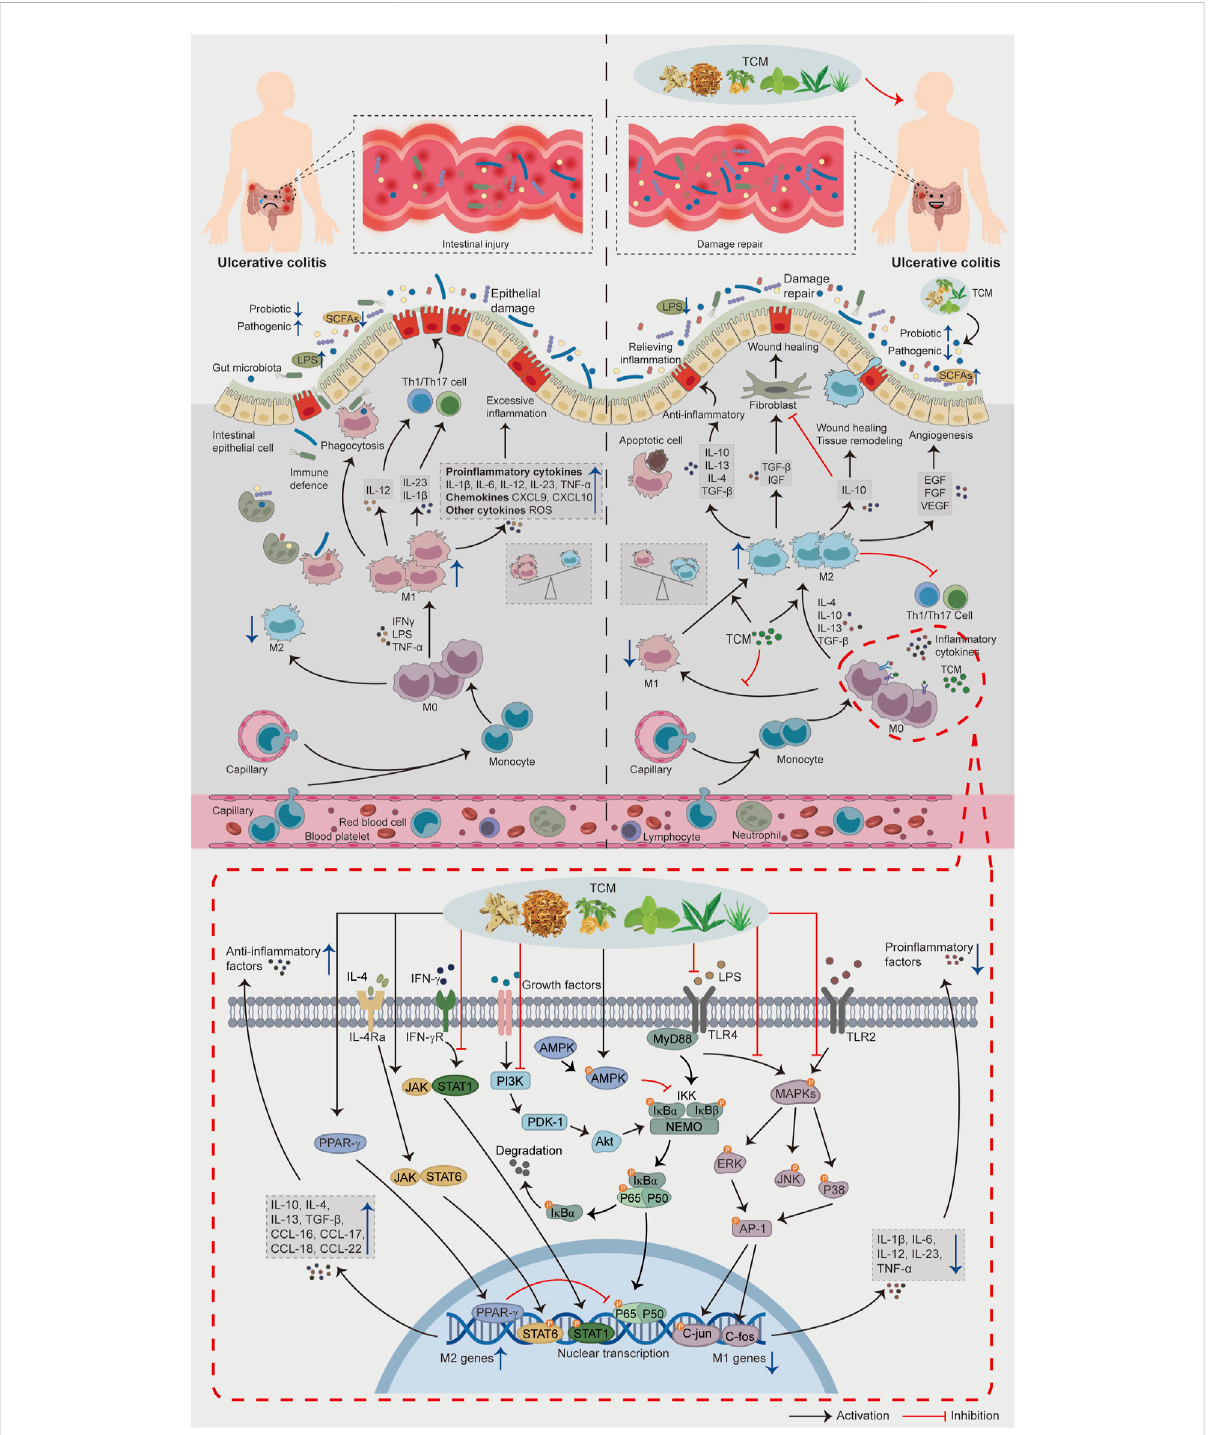
FIGURE 2 The role of intestinal macrophage polarization in the pathogenesis of UC and the potential mechanisms of TCM for UC based on intestinal macrophage polarization. When intestinal in fl ammation occurs in patients with UC, the lamina propria of the intestinal mucosa recruit a large number of monocytes and differentiate into immature M0 macrophages. Induced by a large number of pro-in fl ammatory factors (IFN γ , LPS, TNF- α ), macrophages polarizetowardtheM1phenotypeandsecretealargenumberofpro-in fl ammatorycytokines,chemokines,andin fl ammatorymediators,causingan imbalance in the regulation of intestinal in fl ammation, transforming the physiological in fl ammatory response into pathological intestinal injury and aggravatingtheconditionofUC.Inaddition,M1macrophagescanfurtheraggravatetheintestinalinjurybysecretingIL-12,IL-23,IL-1 β andincreasingTh1/ Th17 activity. In the treatment stage, TCM can promote M2 macrophage polarization and inhibit M1 macrophage polarization by regulating the signaling pathways related to macrophage polarization, regulating gut microbiota and its metabolites, thus reducing the intestinal in fl ammatory response, promoting intestinal tissue repair, and alleviating UC